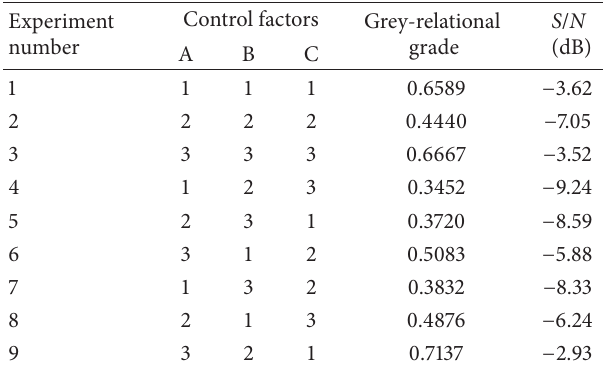
Table 4: Grey-relational grade and S / N ratio. Experiment